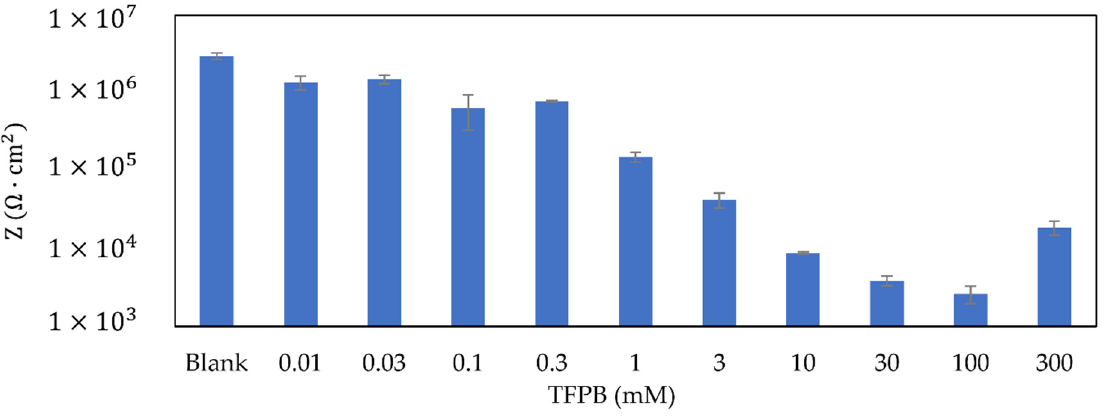
Figure 11. The impedance of the TFPB membrane with different TFPB concentrations.